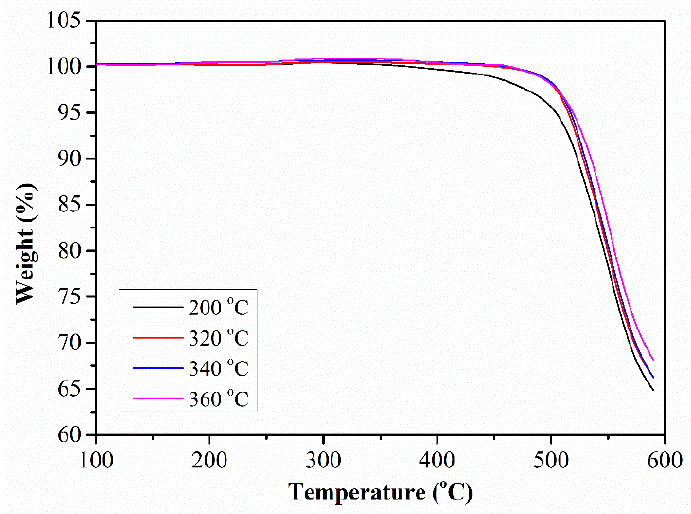
Figure 6. TGA of PEN–OH films heat-treated at different temperatures.